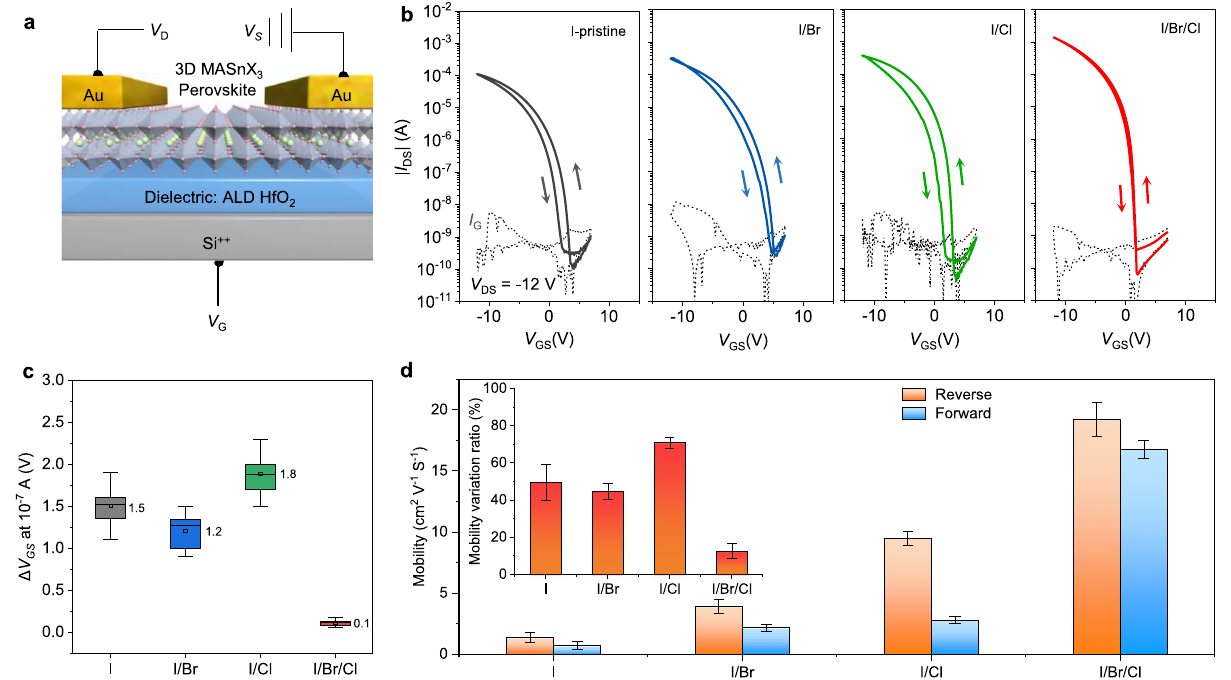
Fig. 1 Electrical characteristics of MASnX 3 perovskite TFTs. a TFT structure used in this work. b Transfer characteristics of the TFTs with different perovskite channel layers. I G : gate leakage current. c Hysteresis statistics of different TFTs. The error bars present standard errors calculated from ten devices per type, and the mean values are labelled. d Histogram of the extracted mobilities from the transfer characteristics under different scan directions. The error bars present standard errors calculated from ten devices per type. The inset shows the variation ratio of the mobility values extracted from reverse ( μ Rev ) and forward ( μ For ) scans, calculated by ( μ Rev − μ For )/ μ Rev × 100%.